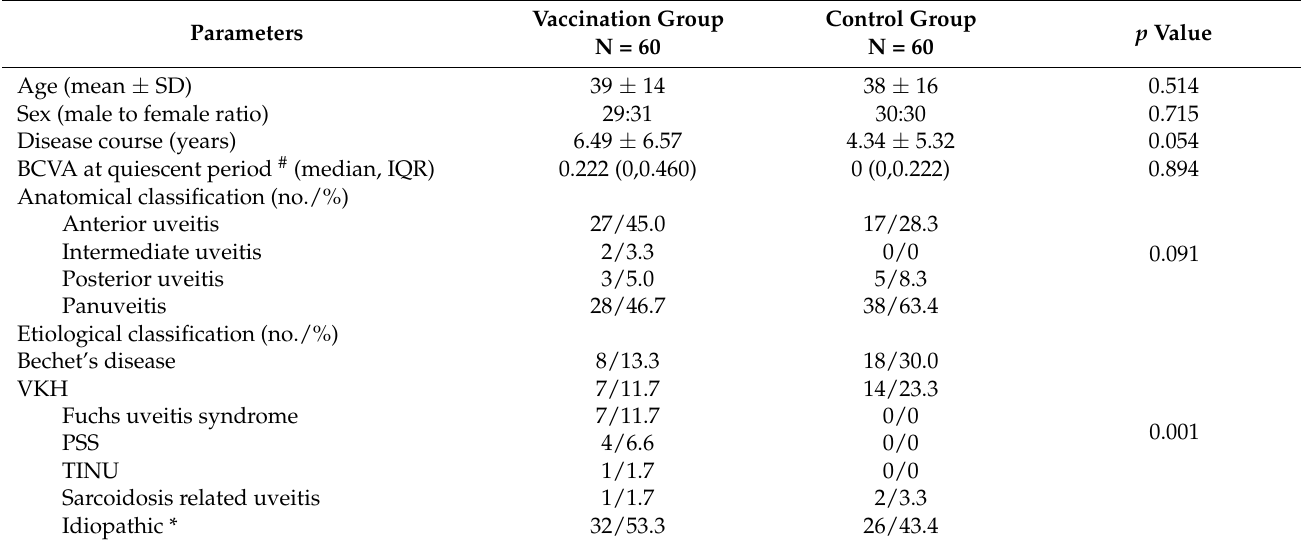
Table 1. Demographic and the clinical features of uveitis